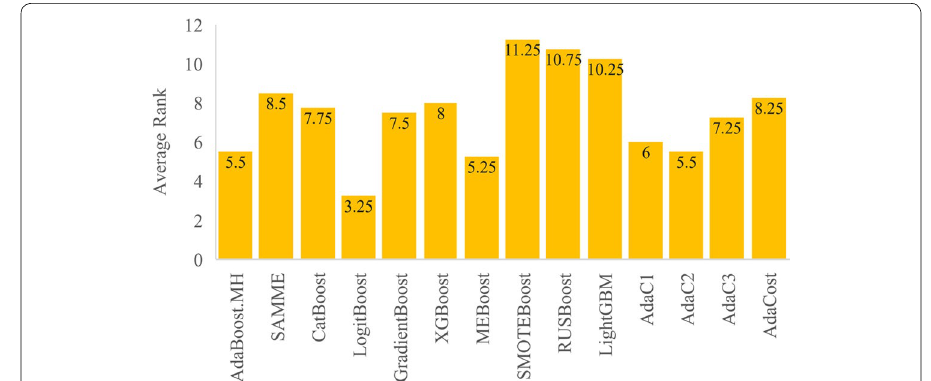
Fig. 5 Average ranks obtained from Friedman test based on the